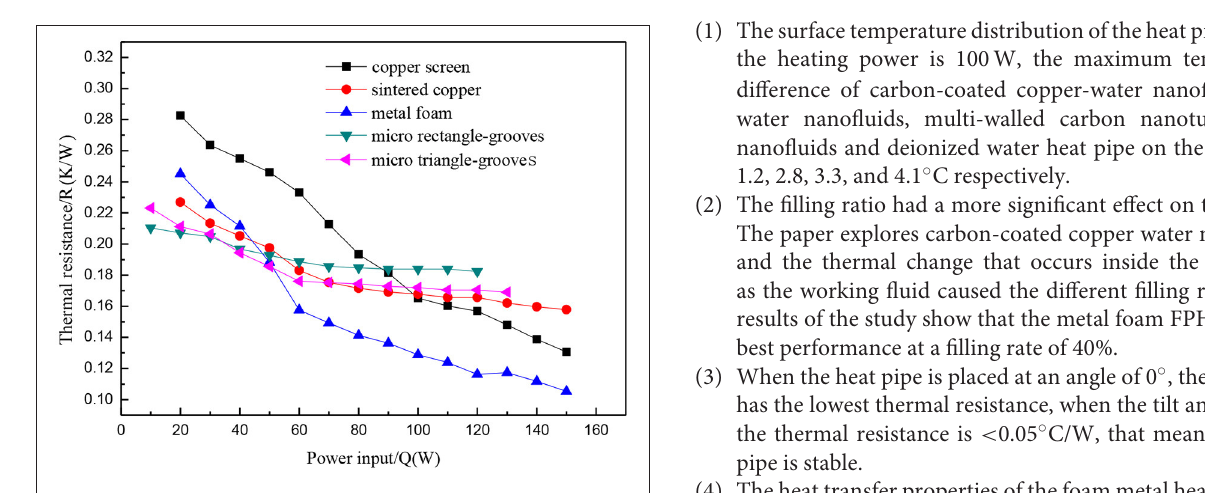
FIGURE 10 | Effect on the thermal resistance of different wick